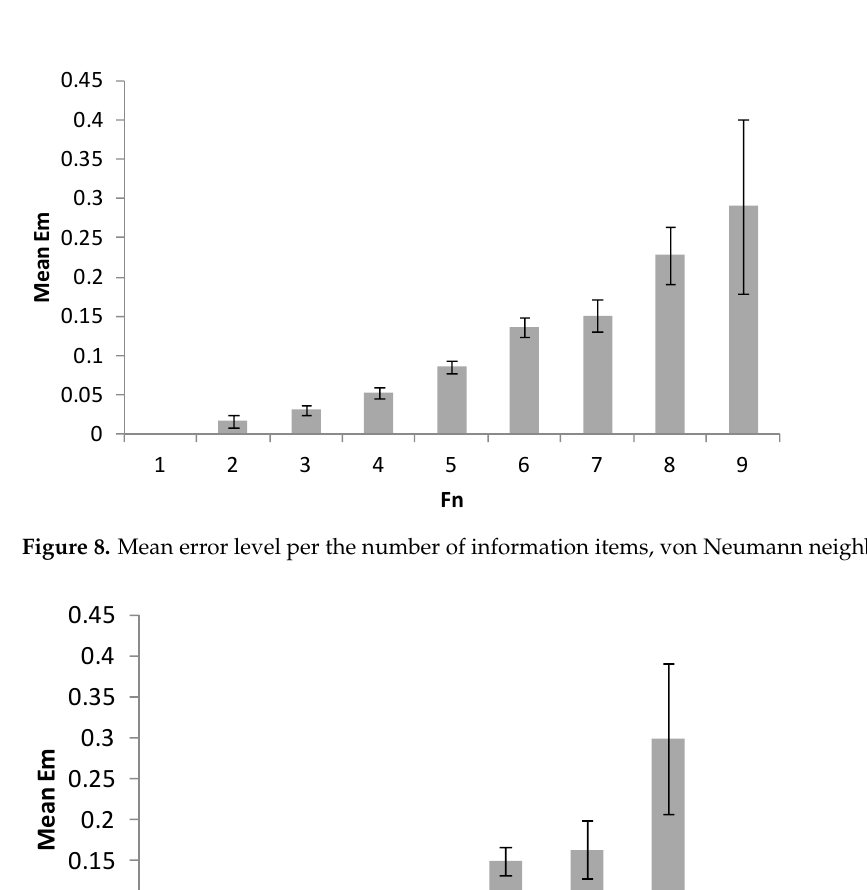
Figure 7. Mean error level per the number of information items, filled cells ( S P ).